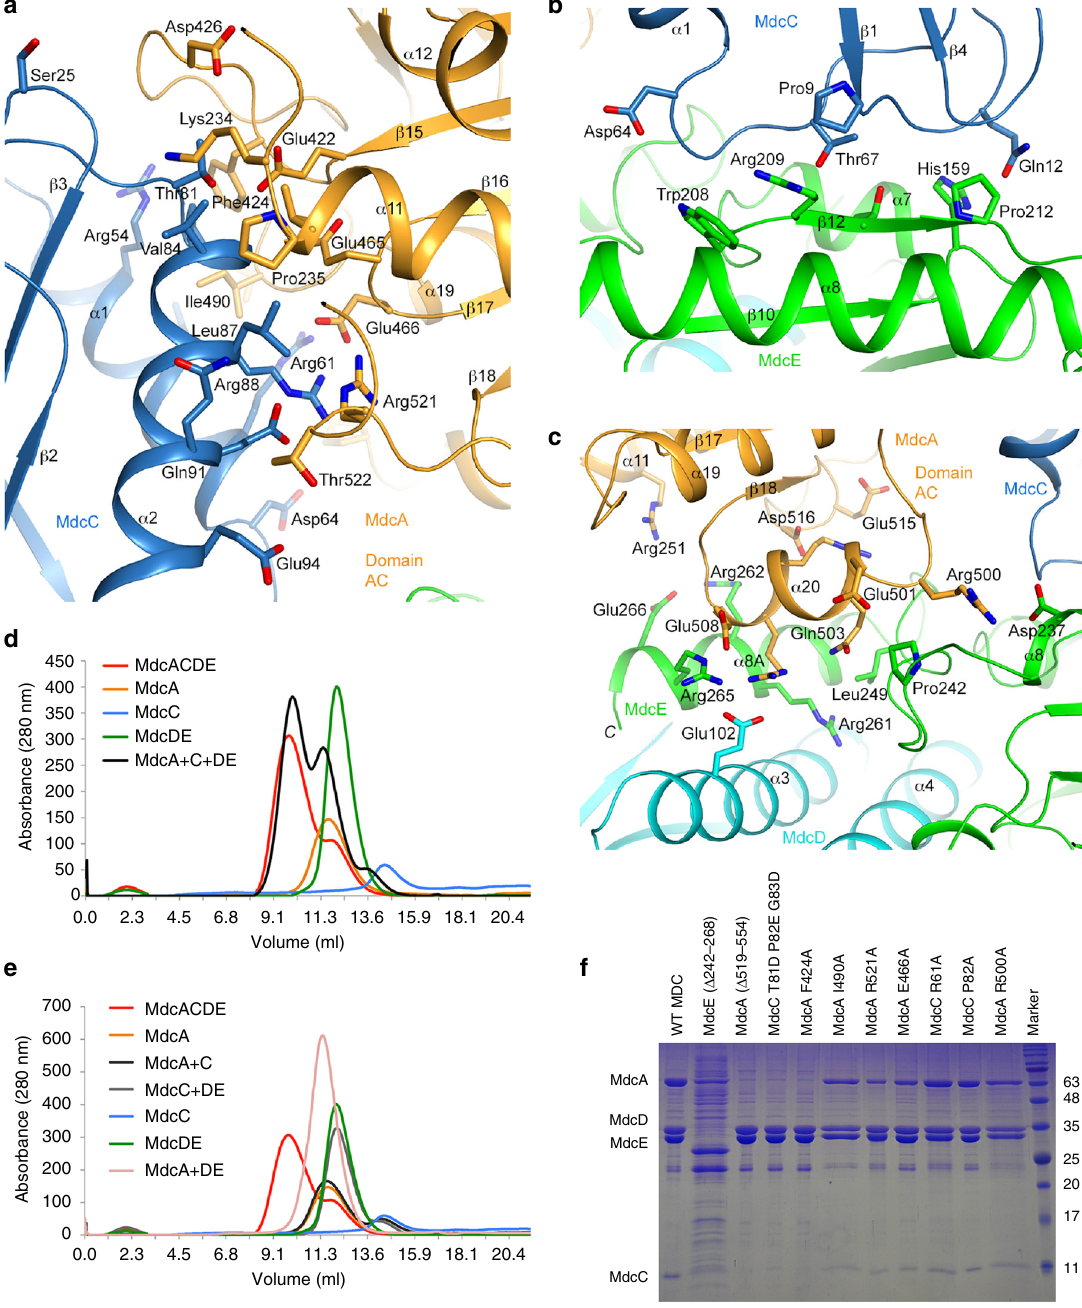
Figure 4 Interactions among the subunits in the MDC hetero-tetramer. a Interactions between MdcA (domain AC, orange ) and MdcC ( light blue ) in MDC. b Interactions between MdcC ( light blue ) and MdcE ( green ) in MDC. c Interactions between MdcA (domain AC, orange ) and MdcE ( green ) in MDC. MdcD ( cyan ) makes a small contribution to this interface. d Gel fi ltration pro fi les showing that the MDC hetero-tetramer can be formed by mixing its subunits. MdcACDE: the hetero-tetramer puri fi ed from co-expressing the four subunits; MdcA+C+DE: mixture of puri fi ed MdcA, MdcC, and MdcD – MdcE subunits. e Gel fi ltration pro fi les showing that the sub-complexes of MDC are not stable, with the exception of MdcD – MdcE. f Nickel pull-down experiments showing the effects of mutations in the MDC interface on hetero-tetramer formation. Only MdcE carries a His tag. The deletion mutations abolished the complex, as no MdcA nor MdcC was pulled down, while most of the single-site mutations had essentially no